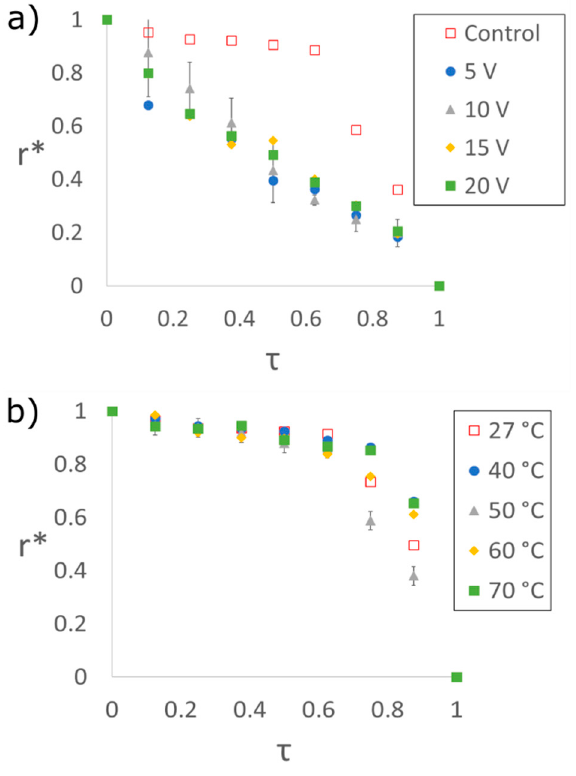
Figure 6. Contact line recession shown as the measured normalized radius (r*) to the edge of an evaporating droplet over the normalized evaporation time ( τ ). ( a ) Control and treated samples using 5.5 mg / mL M13 bacteriophage dispersion under increasing voltage application. For the control sample, r* is nearly constant up to τ = 0.6 indicating a pinned contact line. With an applied voltage, the contact line moves at a near-constant rate, allowing for the self-assembly of SHNs. ( b ) Contact line recession of droplets on heated substrates with no applied field. Each of the measurements illustrates that Joule-heating alone does not unpin the contact line and allows it to recede as is seen with an applied voltage. Error bars in each plot are shown for the condition with the highest error .